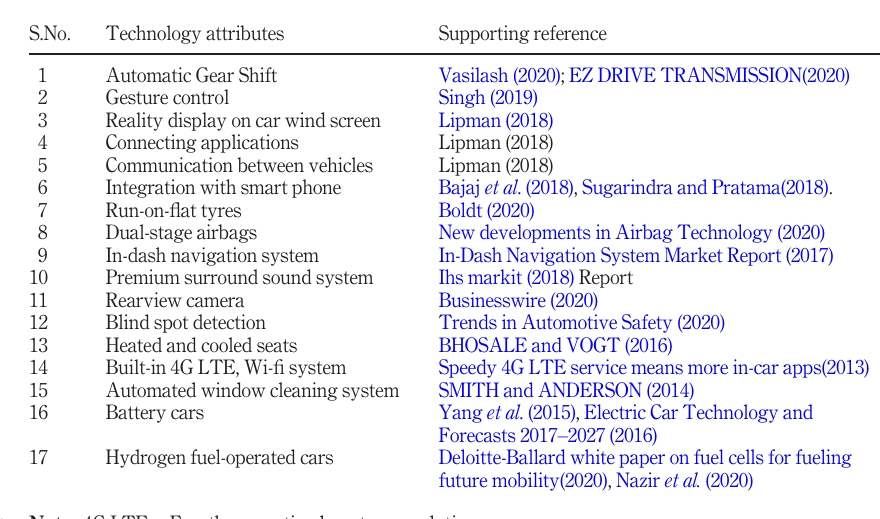
Table 1. Technological attributes and the supporting